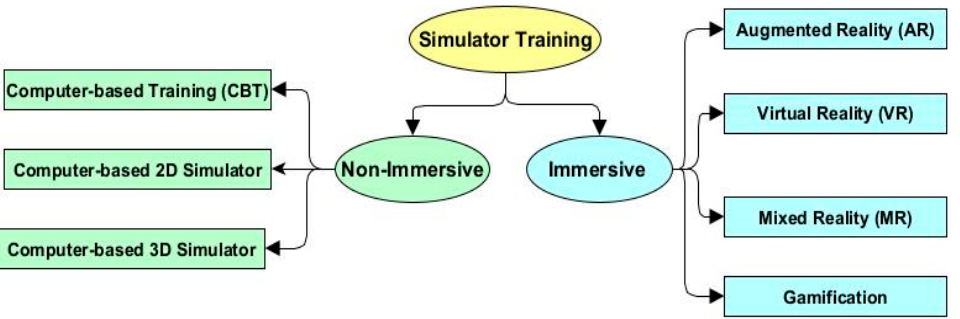
Figure 3. Types of Immersive and Non-immersive Simulators Utilized in Experiential Education and Training.